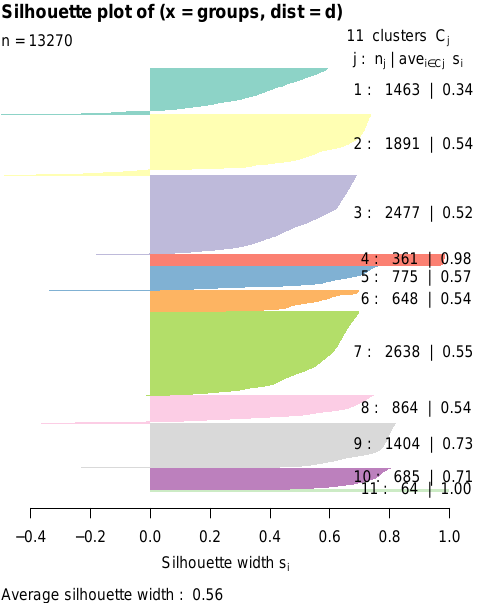
Figure 6. Silhouette coefficient index for each of the model selected